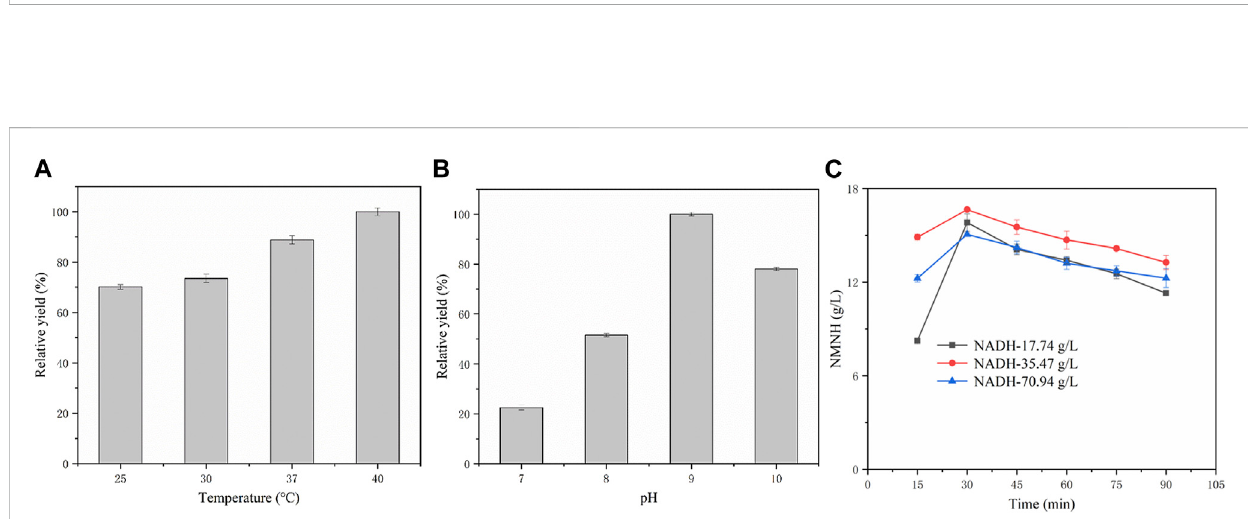
FIGURE 10 Exploration of catalytic process and biosynthesis of NMNH. (A) Relative yields of NMNH at different reaction temperatures. (B) Relative yields of NMNH at different reaction pH. (C) Biotransformation curve of NMNH at different substrate concentrations.